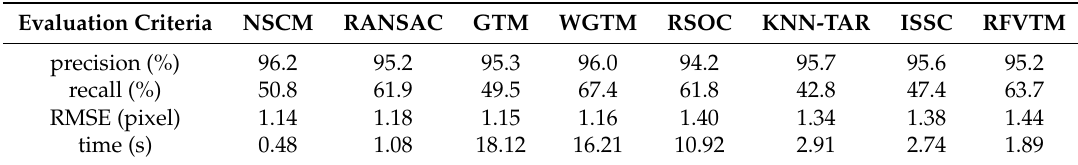
Table 1. Mean precision, recall and RMSE values in NSCM, RANSAC, GTM, WGTM, RSOC, KNN-TAR, ISSC and